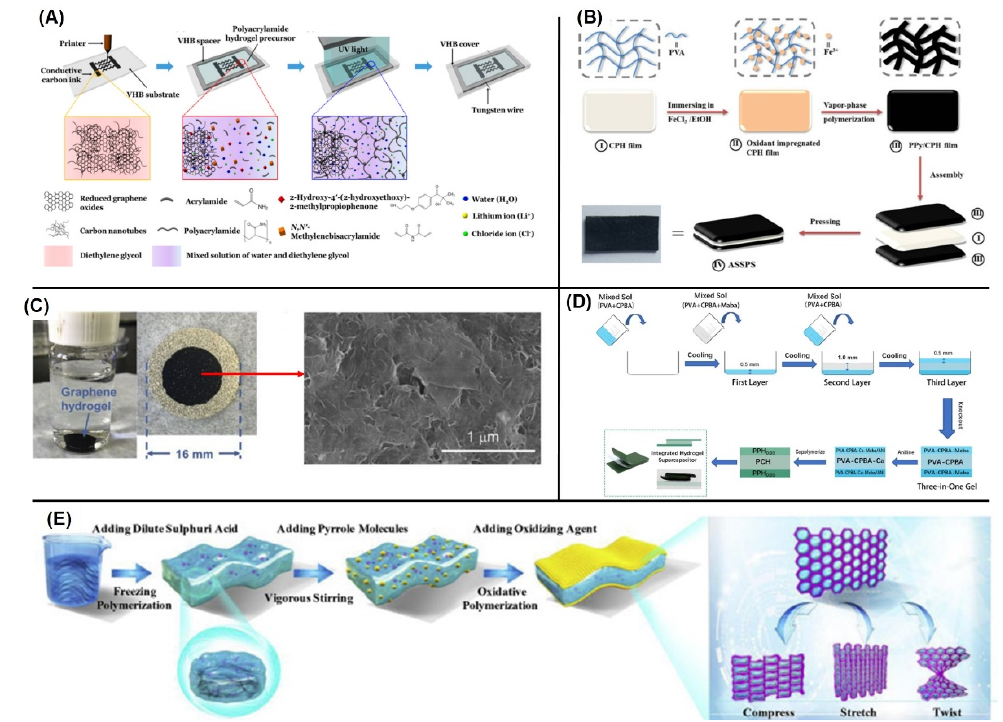
Figure 3. Fabrication process of ( A ) a stretchable supercapacitor by coating ink on a hydrogel elastomer [44], ( B ) PPy-CPH hydrogel-based supercapacitor [45], ( C ) graphene-hydrogel using phenylenediamine-based supercapacitor [46], ( D ) demonstration of a self-healable supercapacitor using all-hydrogel materials [47] and ( E ) all-in-on hydrogel supercapacitor [48]. Reproduced with permission from ref.